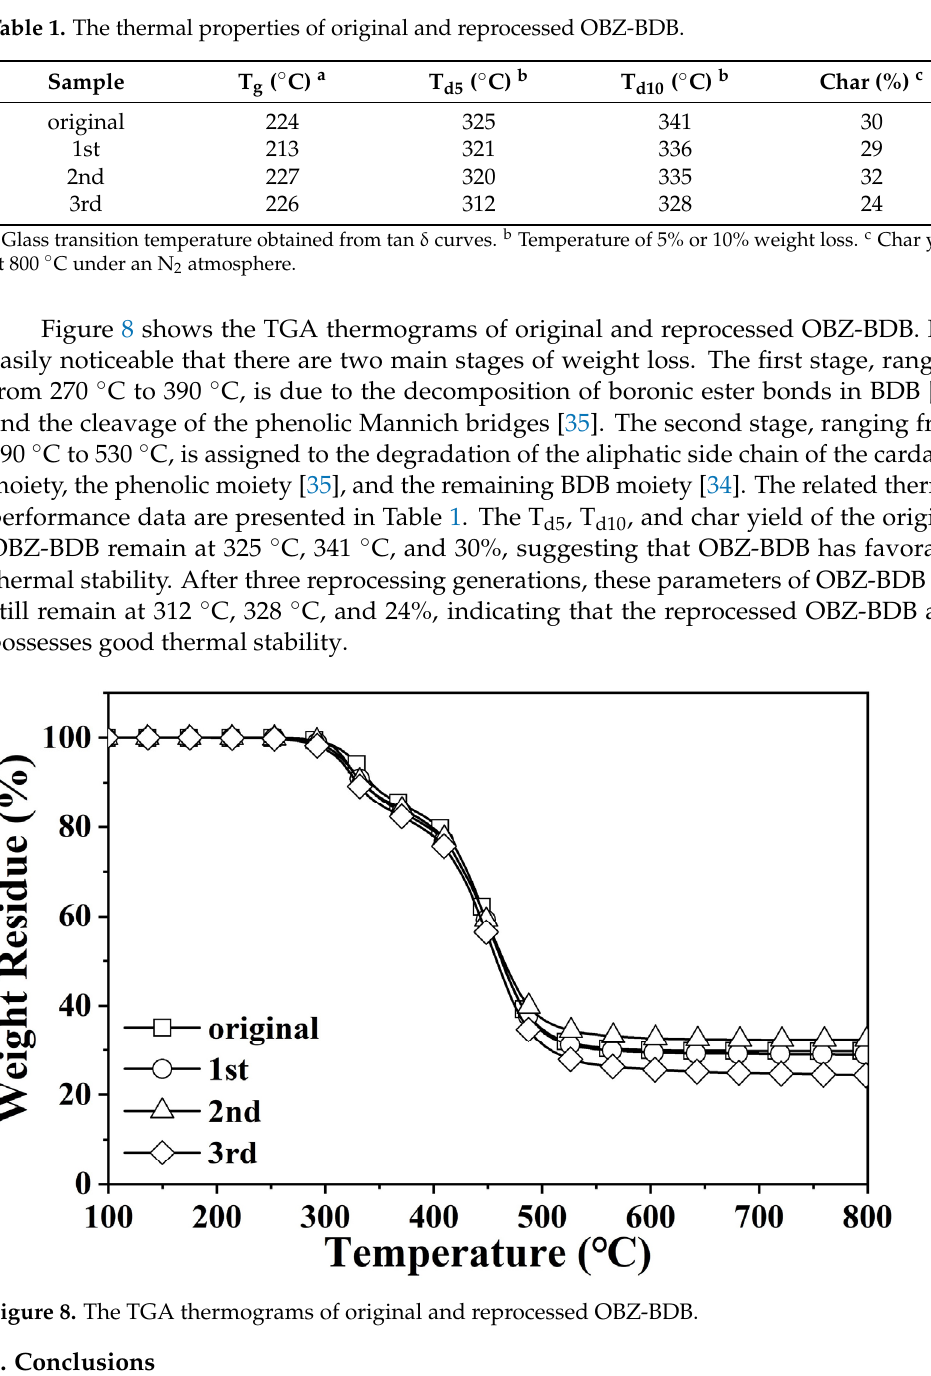
Table 1. The thermal properties of original and reprocessed OBZ-BDB.